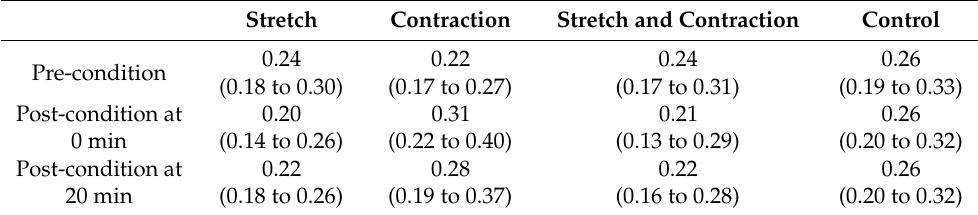
Table 1. Change in spinal-reflex